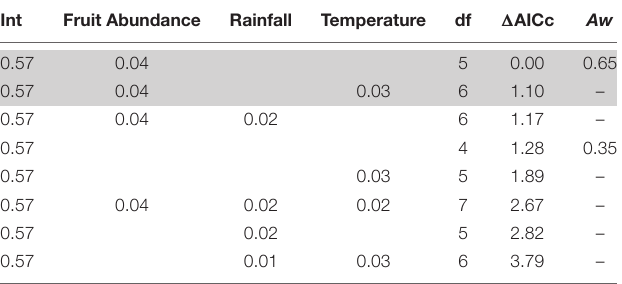
Values = the effect size of continuous predictors included in the model. See Table 1 for the full heading descriptions. ’Gray shading’ = models included in the top model set.